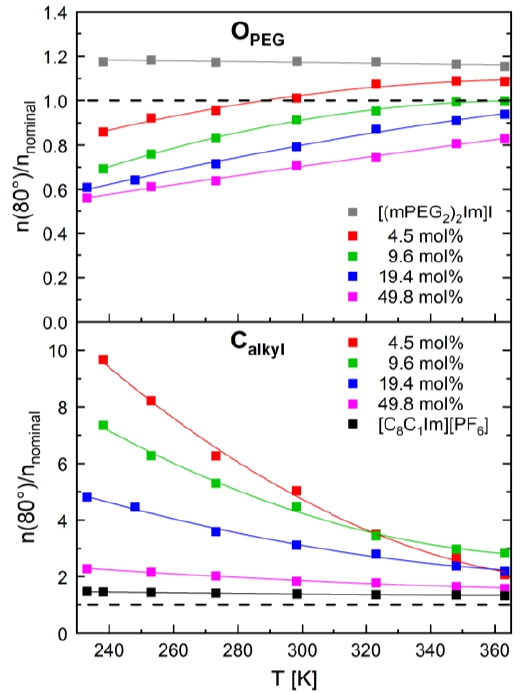
Figure 4. Normalized content n(80°)/n nominal for O PEG ( top ) and C alkyl ( bottom ), derived from the corresponding 80° intensities and their nominal atomic numbers of O PEG and C alkyl for the pure ILs and mixtures for different temperatures (measurements started at 363 K).